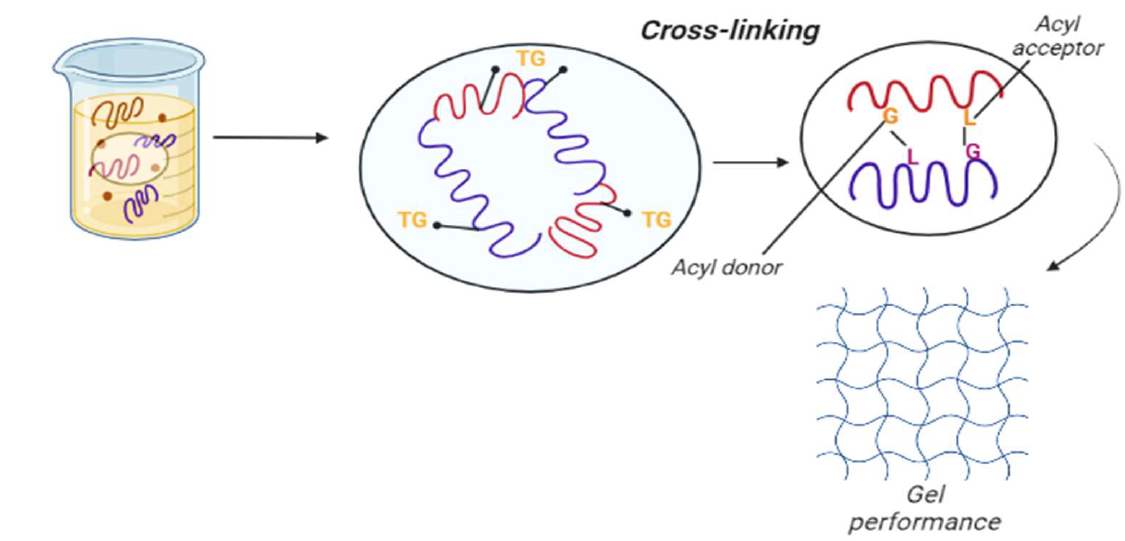
Figure 6. Enzymatic modification of pea proteins by a crosslinking method. Table 4. Different modification methods and their